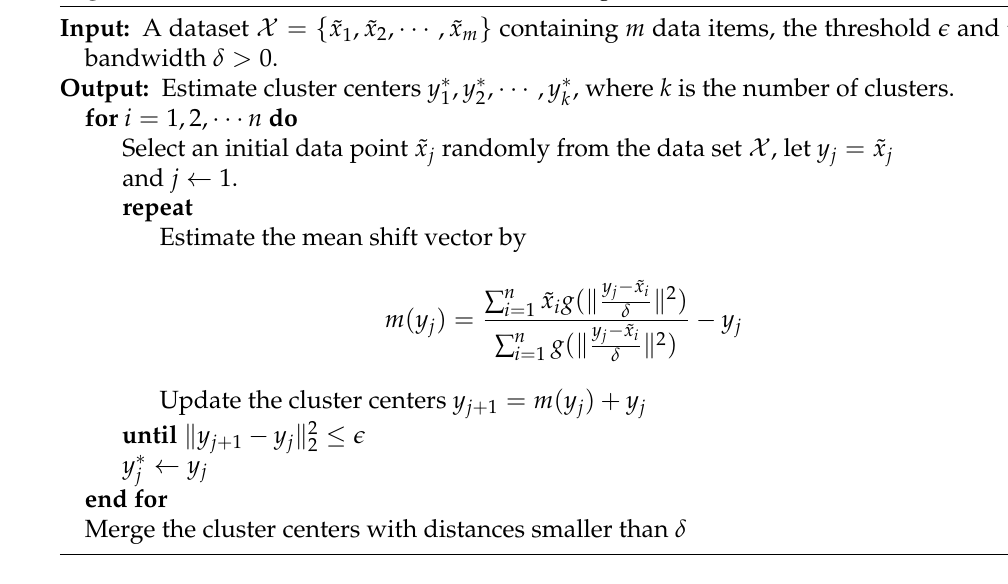
Algorithm 3 The mean shift method for clustering